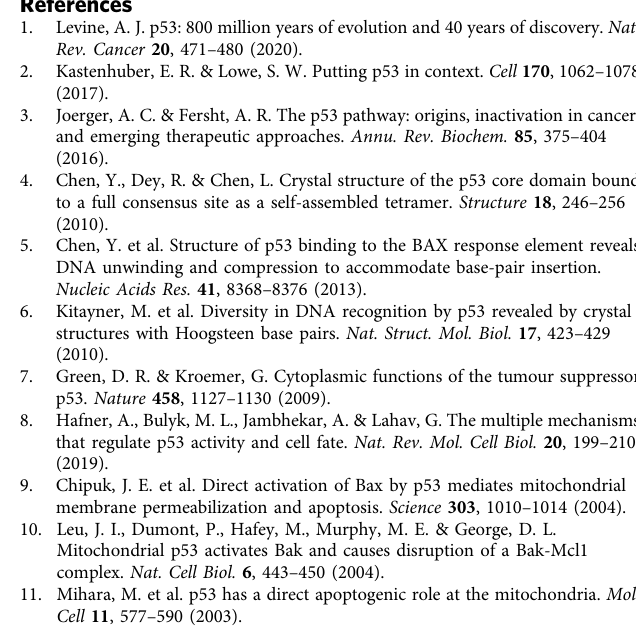
PAGE gel. p53 proteins were detected by western blotting using anti-p53 antibody (abcam, ab26, GR3213177-1, a working concentration of 2 μ g/ml), and GST or GST-BCL-xL was detected by anti-GST tag antibody (Abbkine, 2A8, ATTJA0301, 1:5,000 working dilution). Cell transfection . All plasmids were transfected with Lipofectamine 2000 (Invi- trogen, 11668027) according to the manufacturer ’ s protocol. The transfection ef fi ciency was veri fi ed by western